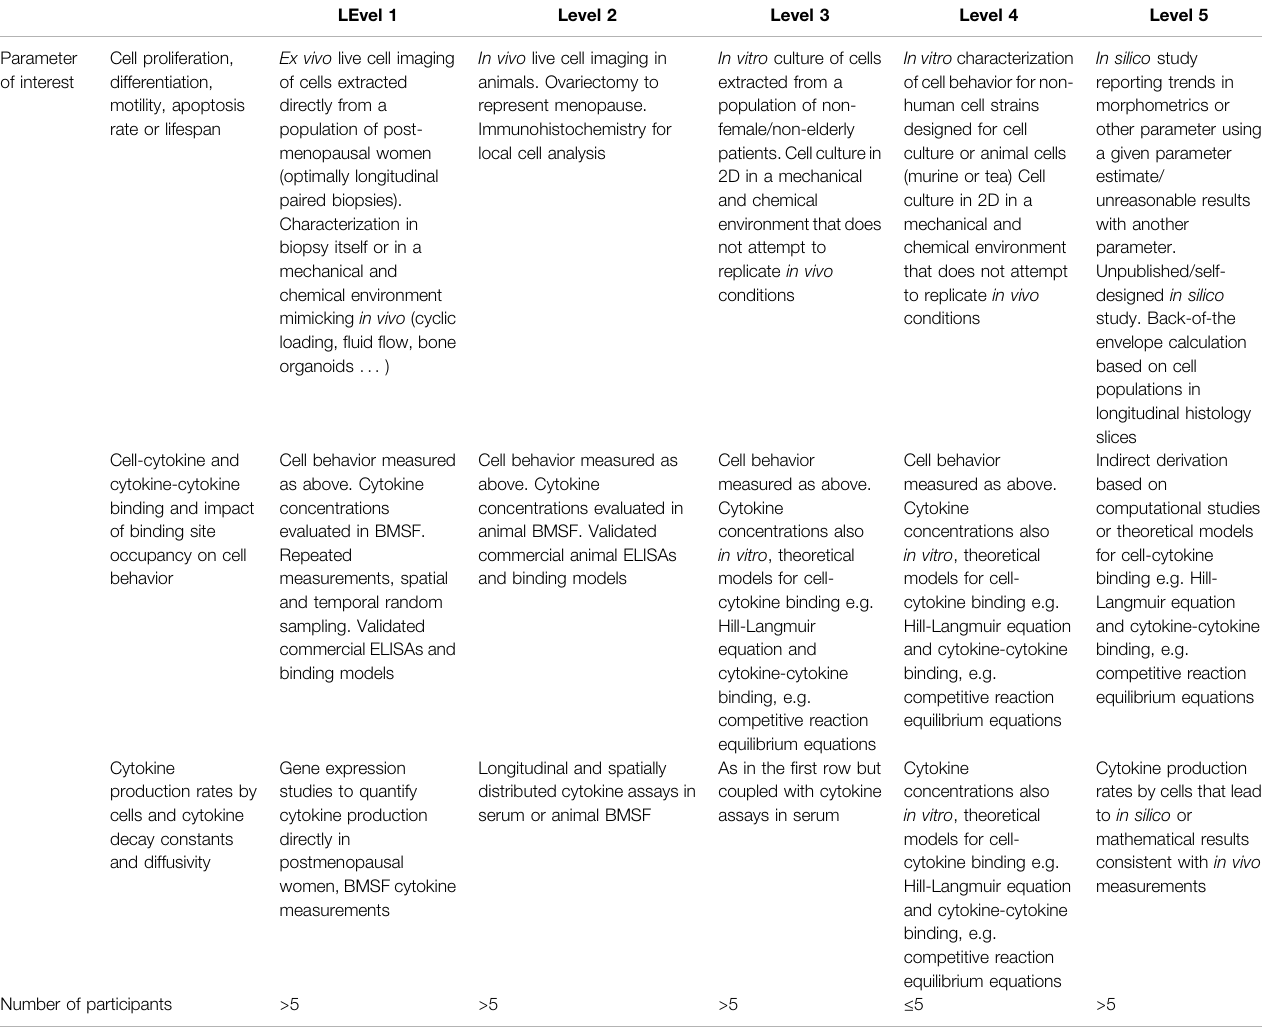
TABLE 12 | Levels of Evidence approach to reduce the parameter range for missing parameters in micro-MPA models or bone cell population dynamics models of osteoporosis and its treatments in postmenopausal women. Inspired by the Levels of Evidence approach of the Oxford Centre for Evidence-Based Medicine (Levels of Evidence Working Group,